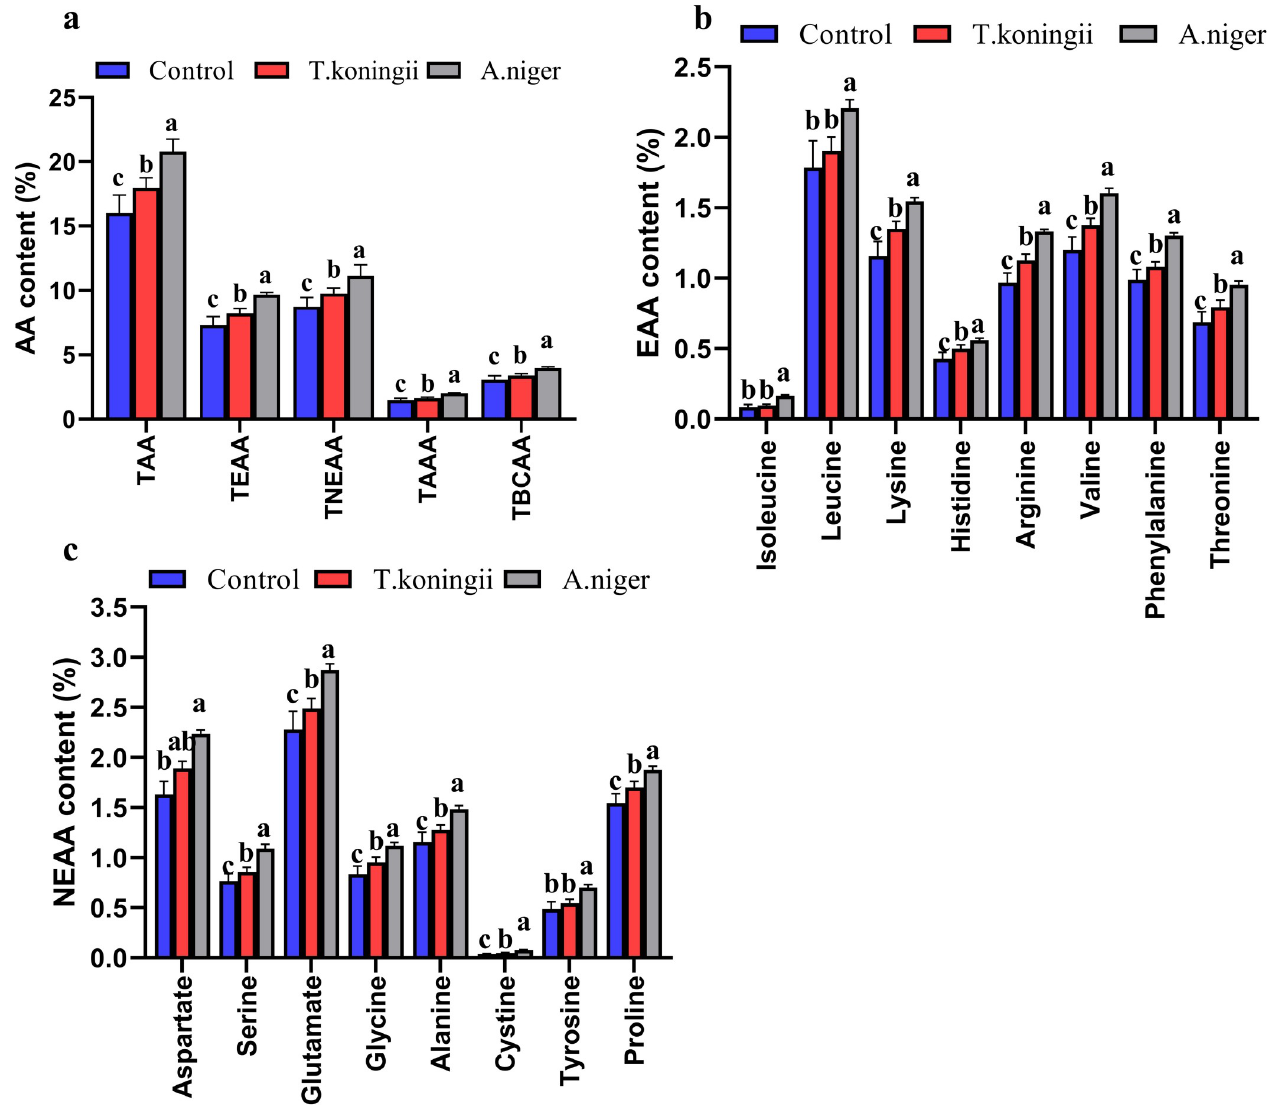
Fig 3. Hydrolytic amino acids in the fermented tea dregs. TAA, total amino acids; TEAA, total essential amino acids; TNEAA, total non-essential amino acids; TAAA, total aromatic amino acids; TBCAA, total branched-chain amino acids. Values with the same letters were not significantly different ( P < 0.05).